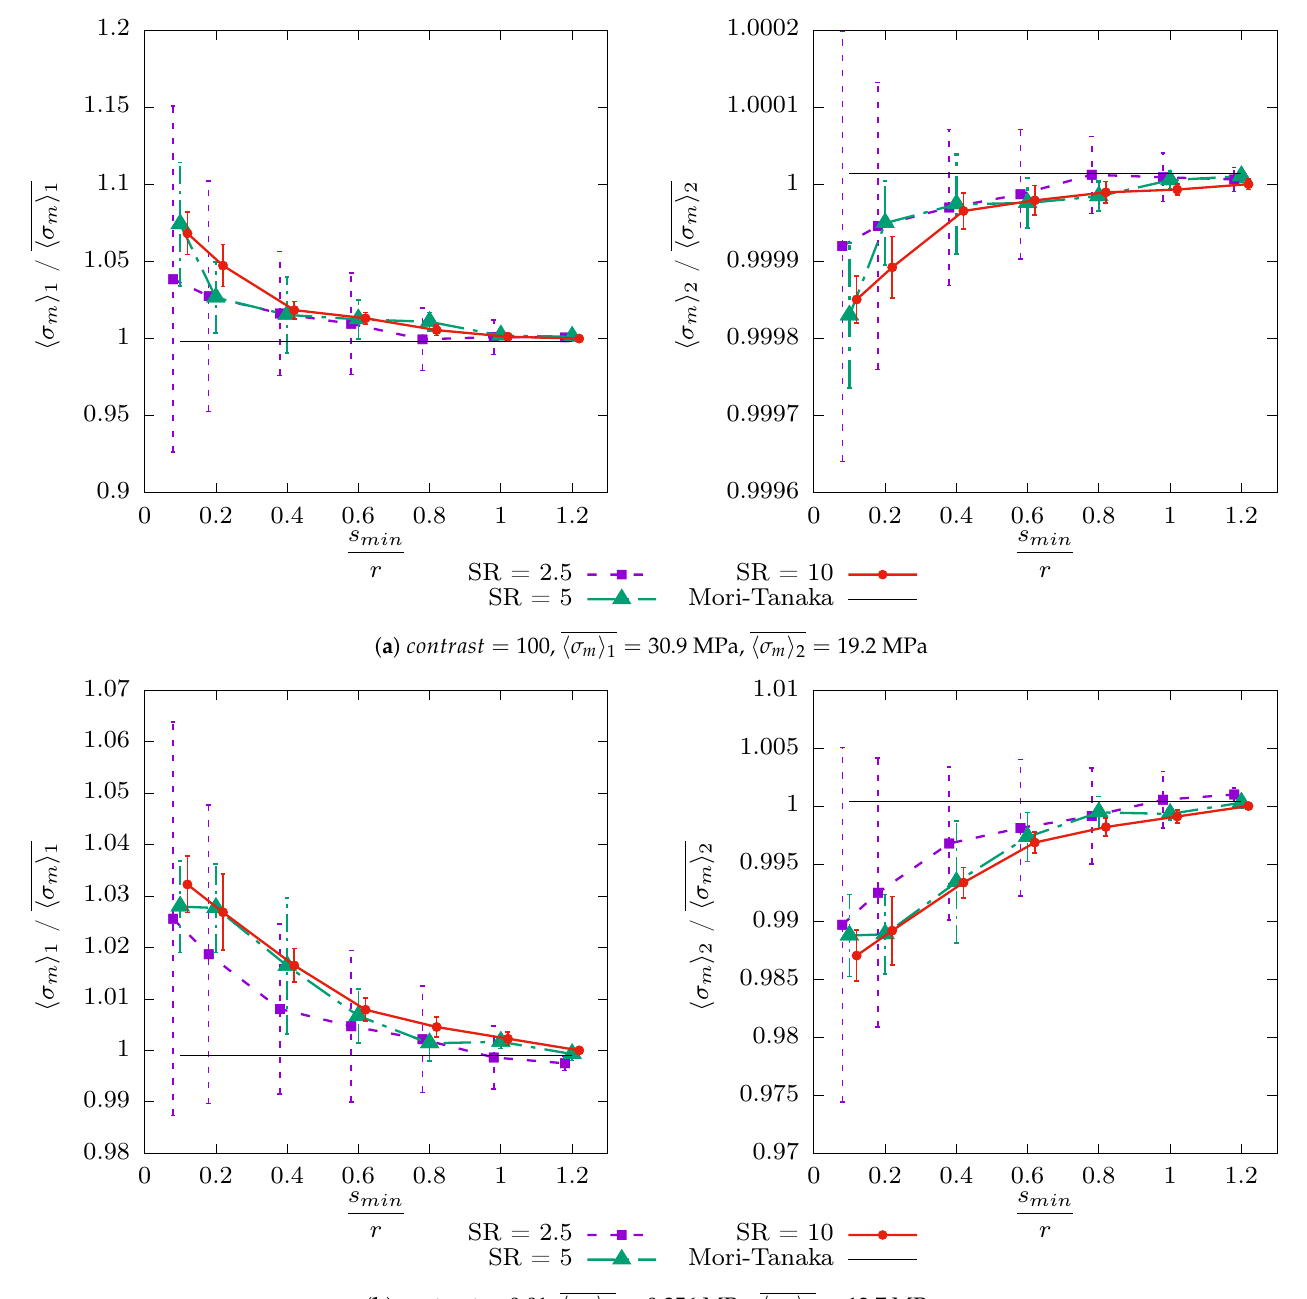
Figure 5. Mean values and standard deviations on the mean value for the first moment of hydrostatic stress by phase as a function of the packing parameter s min / r ( r = 10 µ m) for a volume fraction of inclusions f v = 13.4 %. For clarity, the error bars and dots are slightly shifted around for each studied minimum